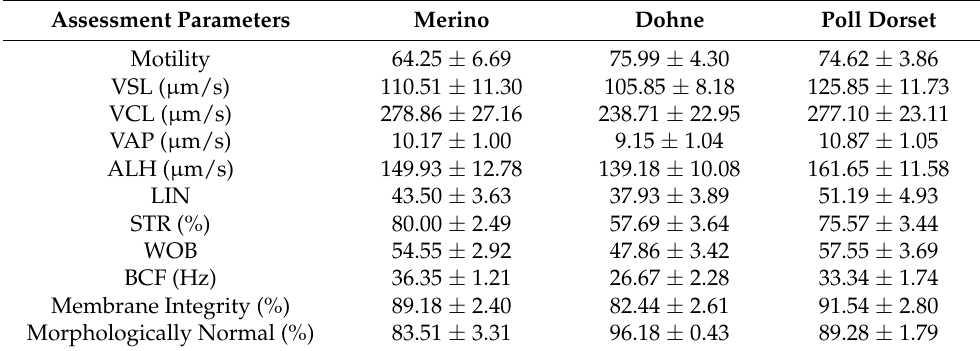
Table 1. Semen parameters (Mean ± SE) assessed via Computer Assisted Semen Analysis (CASA) for Dohne, Merino, and Poll Dorset.